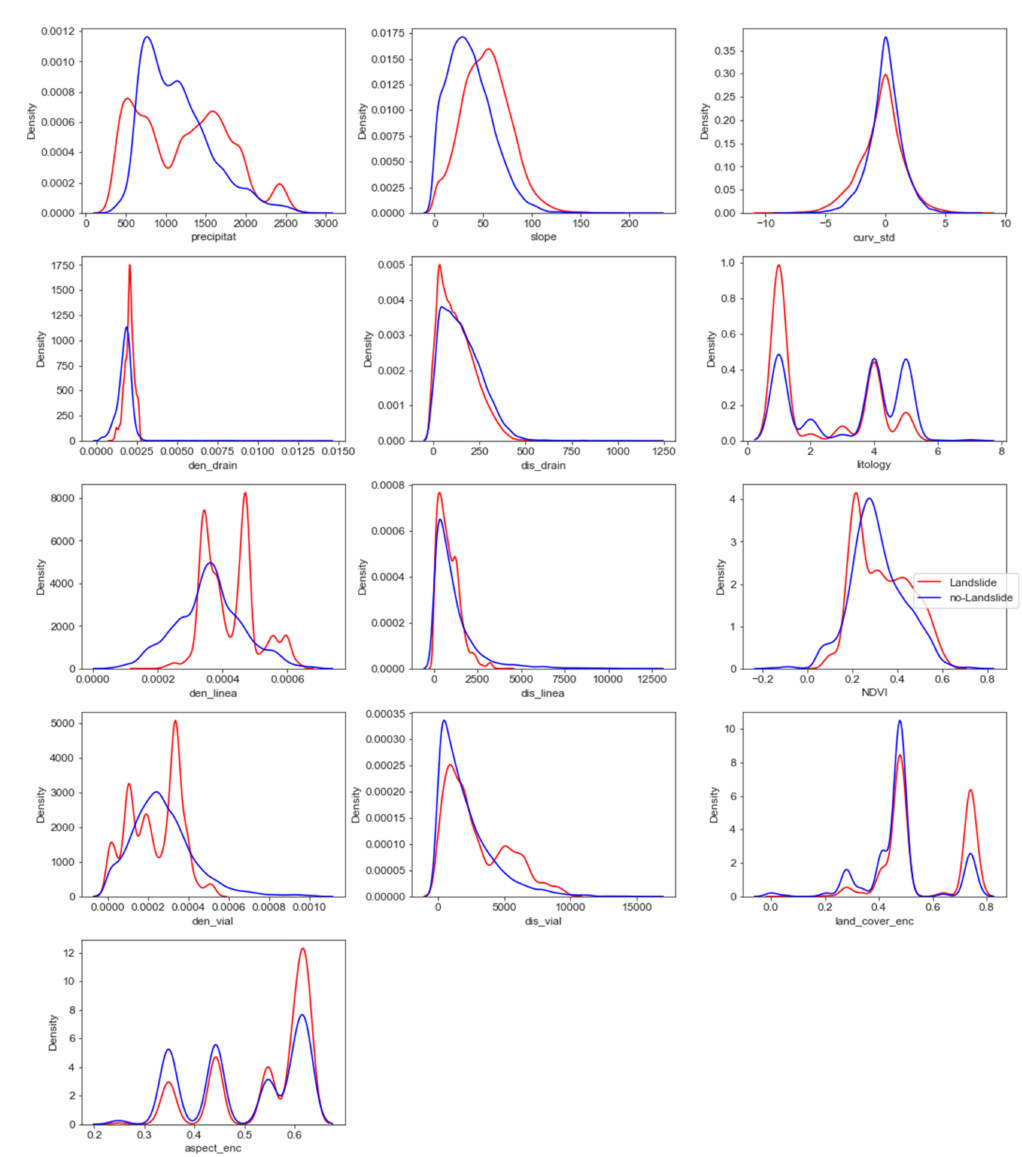
Figure 3. Graphs of distributions of the explanatory variables according to the variable to be explained (see text for